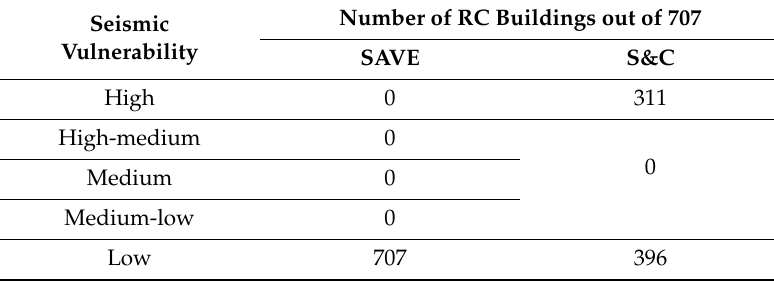
Table 13. Comparisons of vulnerability judgments for 707 RC buildings given by the methods of Group